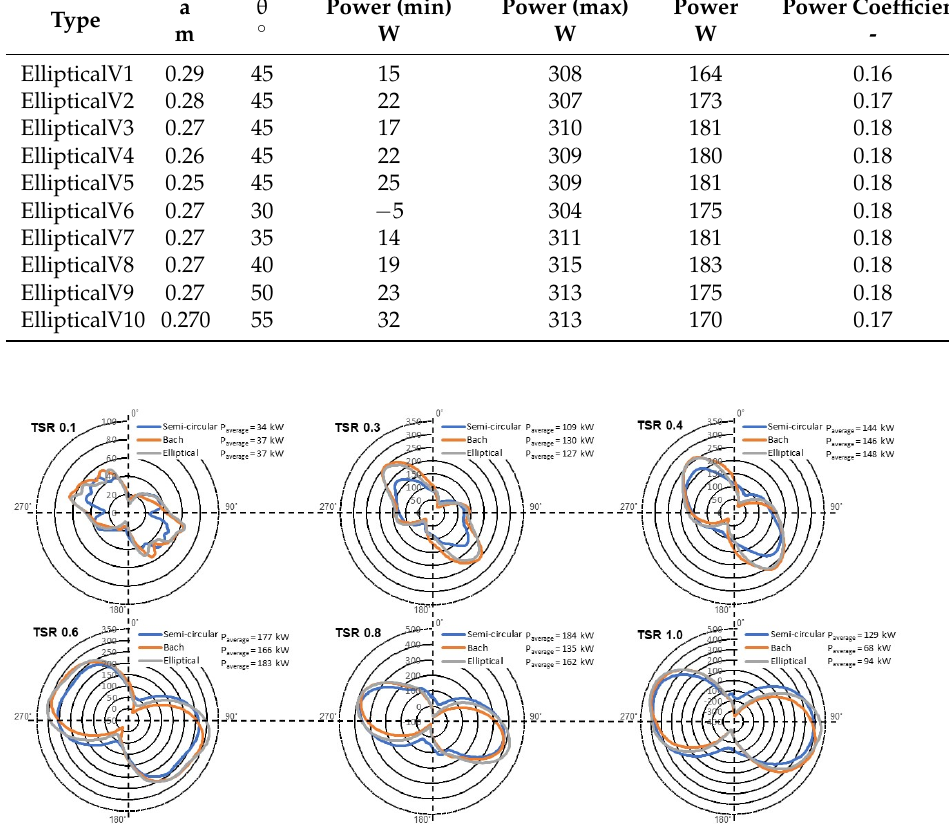
Figure 10. Comparison of rotor power during one rotation according to TSR.